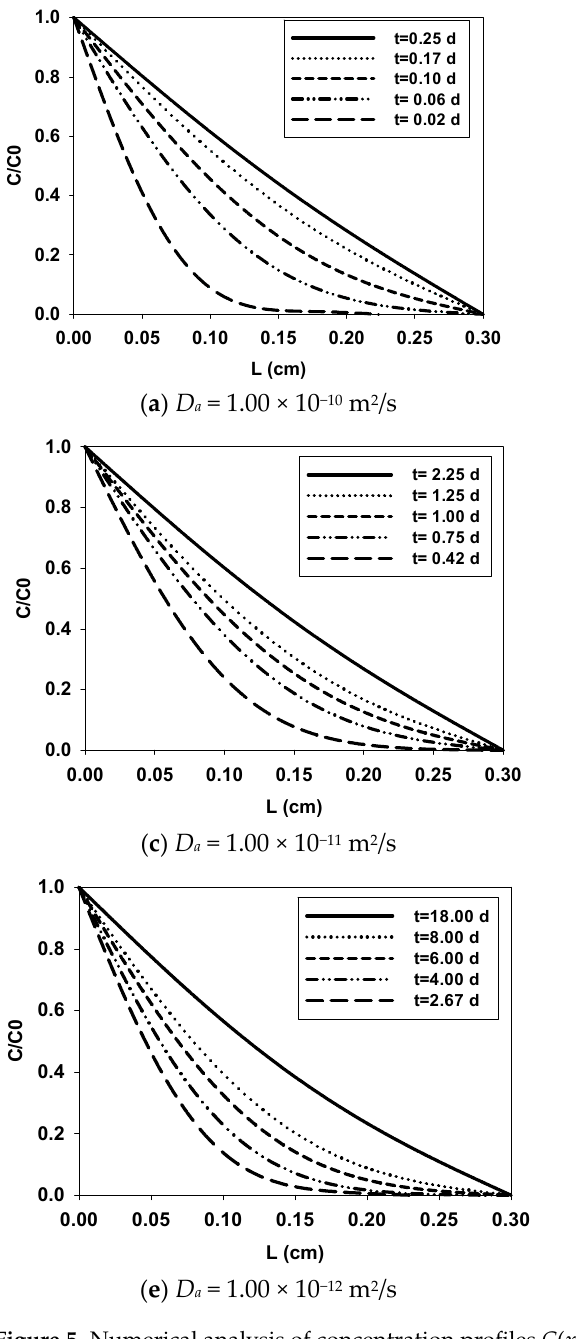
Figure 5. Numerical analysis of concentration profiles C ( x,t ): ( a ) temporal: C ( x,t ) at D a = 1 × 10 − 10 m 2 /s and ( b ) spatial: C ( x,t ) at D a = 1 × 10 − 10 m 2 /s; ( c ) temporal: C ( x,t ) at D a = 1 × 10 − 11 m 2 /s and ( d ) spatial: C ( x,t ) at D a = 1 × 10 − 11 m 2 /s; ( e ) temporal: C ( x,t ) at D a = 1 × 10 − 12 m 2 /s and ( f ) spatial: C ( x,t ) at D a = 1 × 10 − 12 m 2 /s. Table 5. Steady-state time in temporal and spatial variation with different D a values.